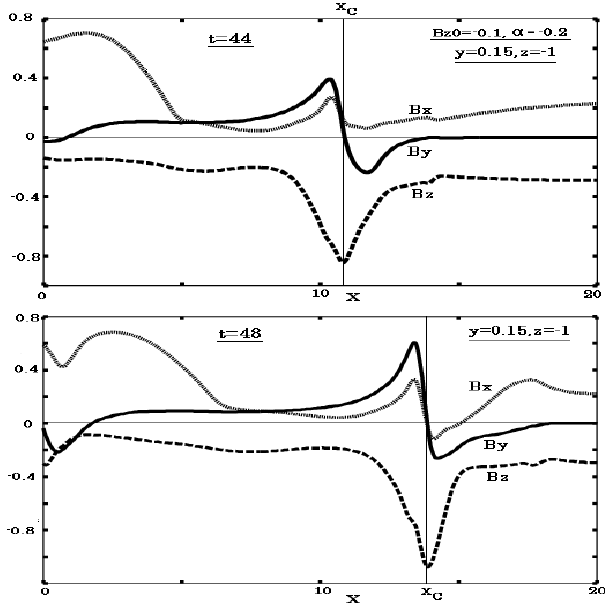
Figure 13: x-directional proflles of magnetic fleld compo- nents B x ; B y and B z at difierent locations of z at y = 1 : 5 at time t = 41 for the case of B z 0 = 1 : 0 at times ¡ 0 : 1 and fi = 0 : 2, where ¡ ¡